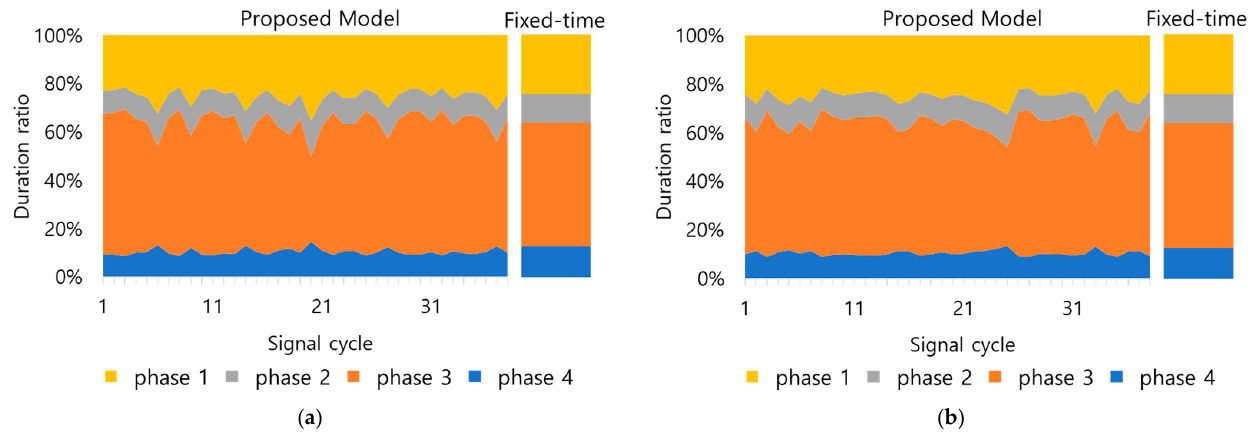
Figure 4. Phase duration ratio of scenario 1: ( a ) Left intersection; ( b ) Right